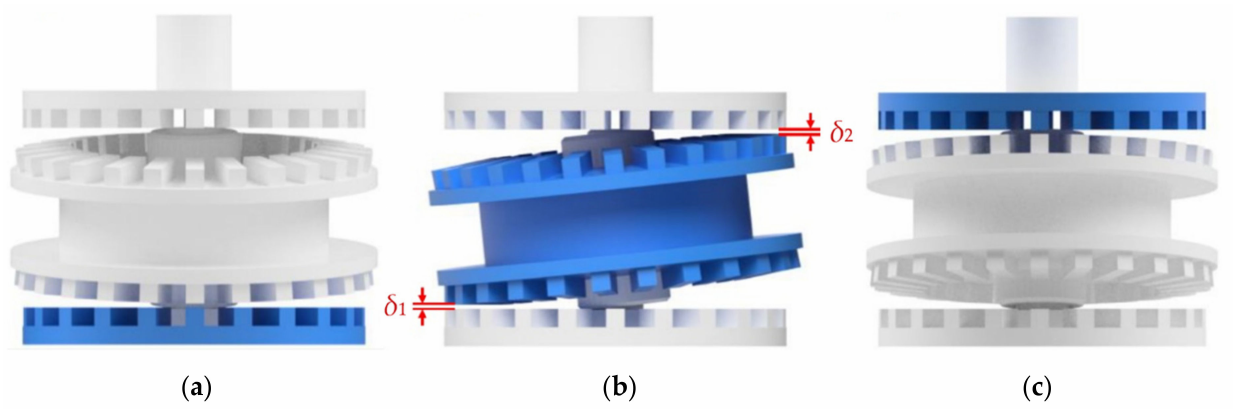
Figure 6. The components of a magnetic precession gear (MPG) for the calculation of: ( a ) torque T base acting on the base of the gear (immovable ring), ( b ) torque T in acting on the intermediate ring (input shaft), and ( c ) output torque T out acting on the output